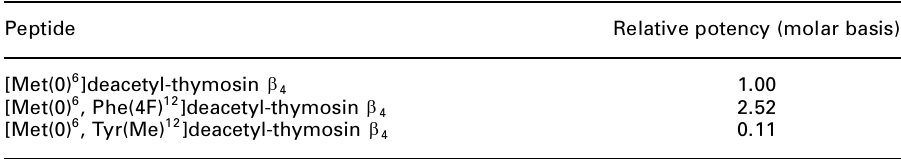
Table 4. Relative potencies of synthetic [Met(0) 6 ]deacetyl-thymosin b 4 and its analogs on suppression of carrageenin-induced footpad swelling in the mouse paw Peptide Relative potency (molar basis) [Met(0) 6 ]deacetyl-thymosin b